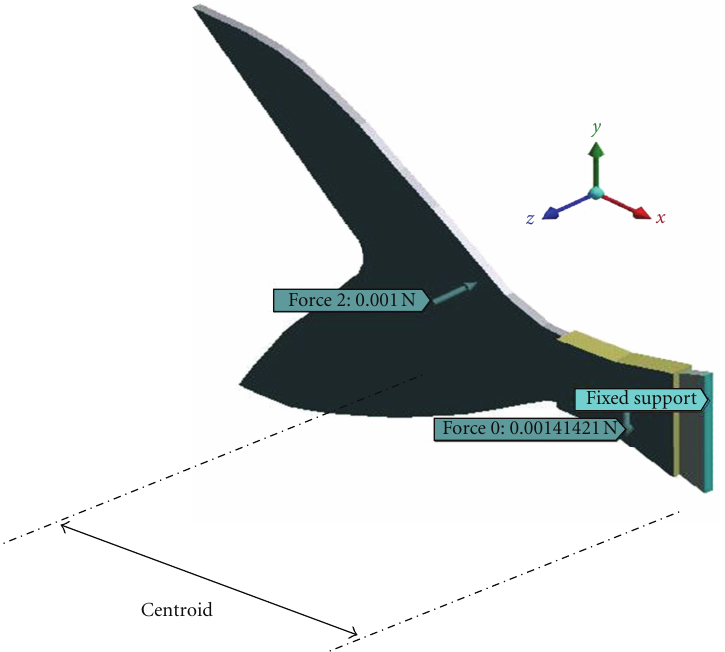
Figure 20: The simulation inputs: 0.001 N on the fin, 0.00141421 N (0.001N— z -axis, 0.001 N— x -axis) on the plywood support.